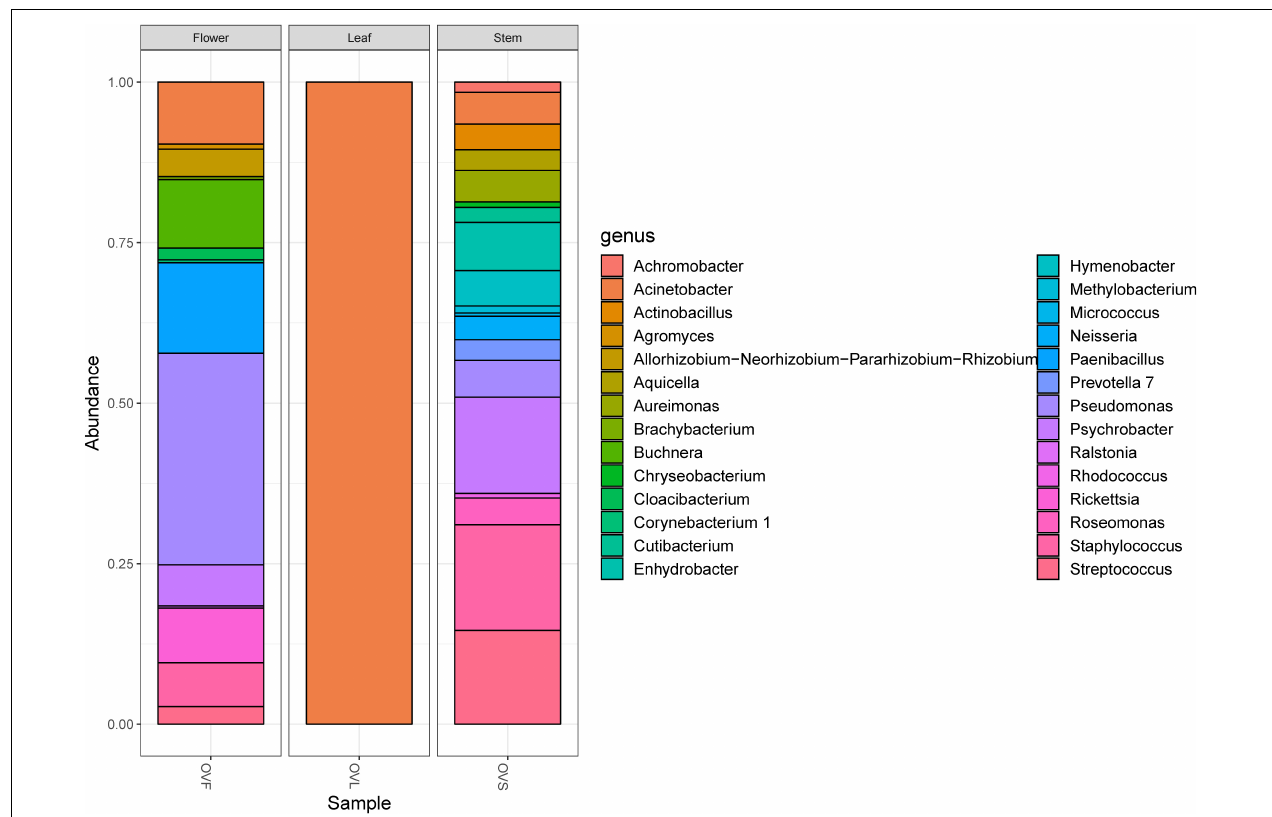
FIGURE 1 | Bar plot showing the relative abundances of bacterial genera in each sample. OVF = flower, OVL = leaf, OVS = stem